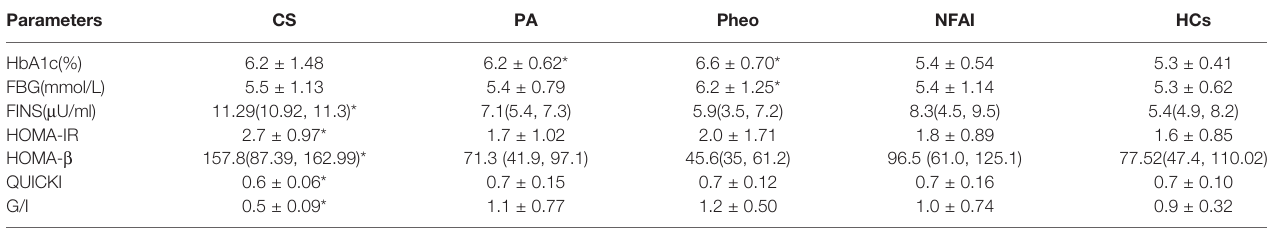
TABLE 2 | Metabolic parameters in ADs and